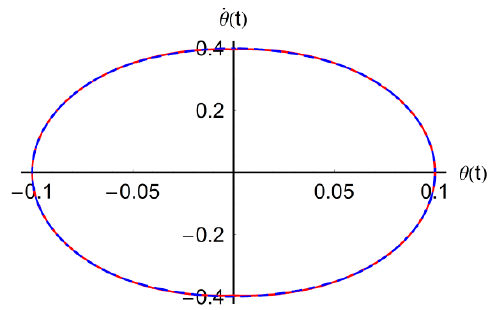
Figure 21. Phase plane for A = 0.4, L = 0.6. Figure 7. Phase plane for A = 0.1, a = 0.6, L = 0.6. _____ numerical_ _ _ _approximate solution (41). Figure 7. Phase plane for A = 0.1, a = 0.6, L = 0.6.